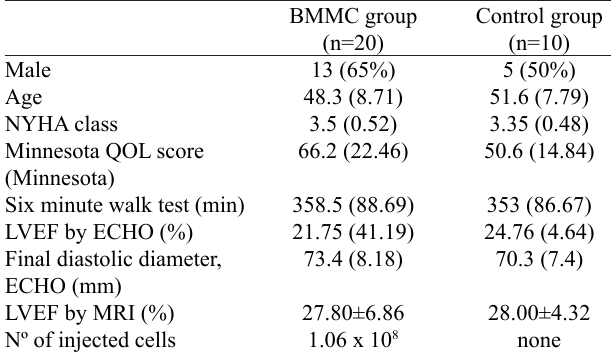
Table 1. Baseline patients